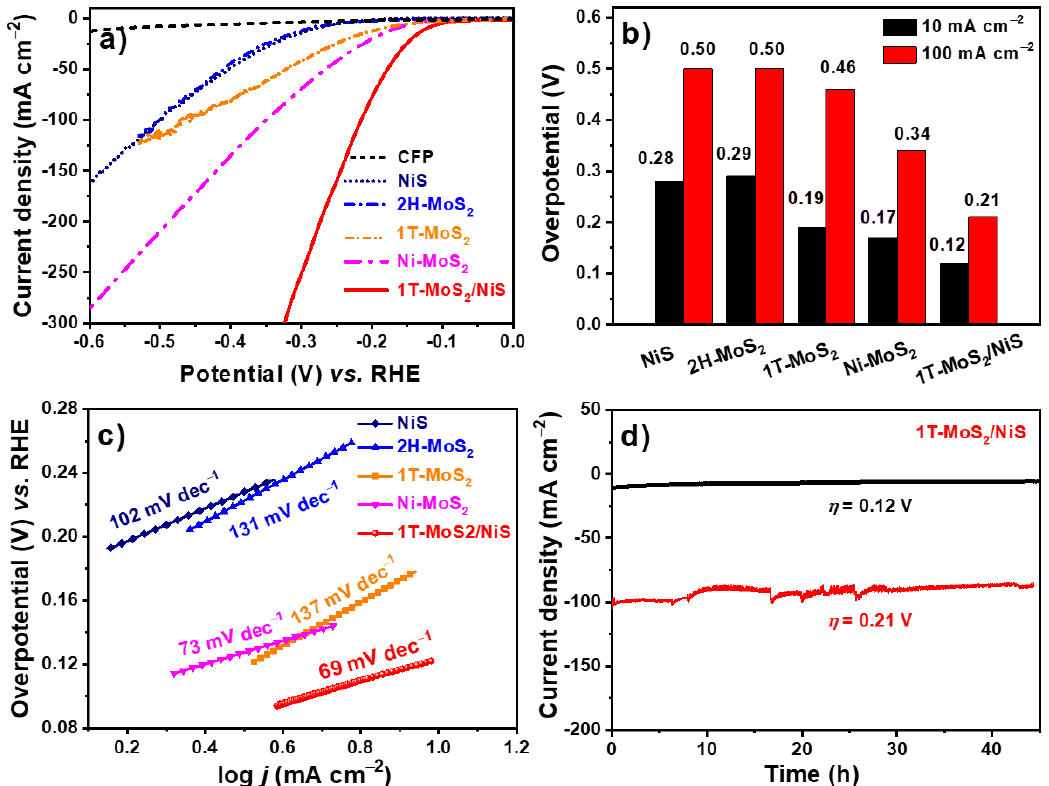
Figure 4. The electrochemical characterization of all electrocatalysts in 1.0 M KOH. ( a ) Polarization curves (without iR correction) and corresponding ( b ) overpotential at a current density of 10 mA cm −2 and 100 mA cm −2 and ( c ) Tafel plots; ( d ) durability tests of the 1T-MoS 2 /NiS catalyst at a constant potential of −0.12 V and −0.21 V vs. RHE.